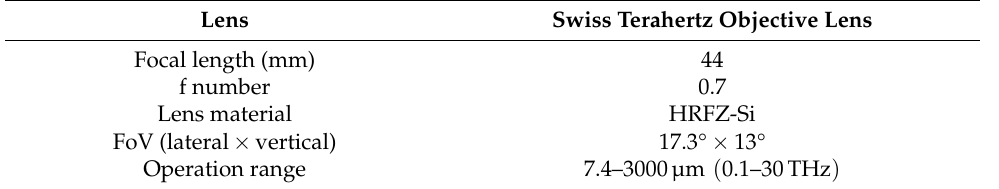
Table 2. Technical specification of the lens.